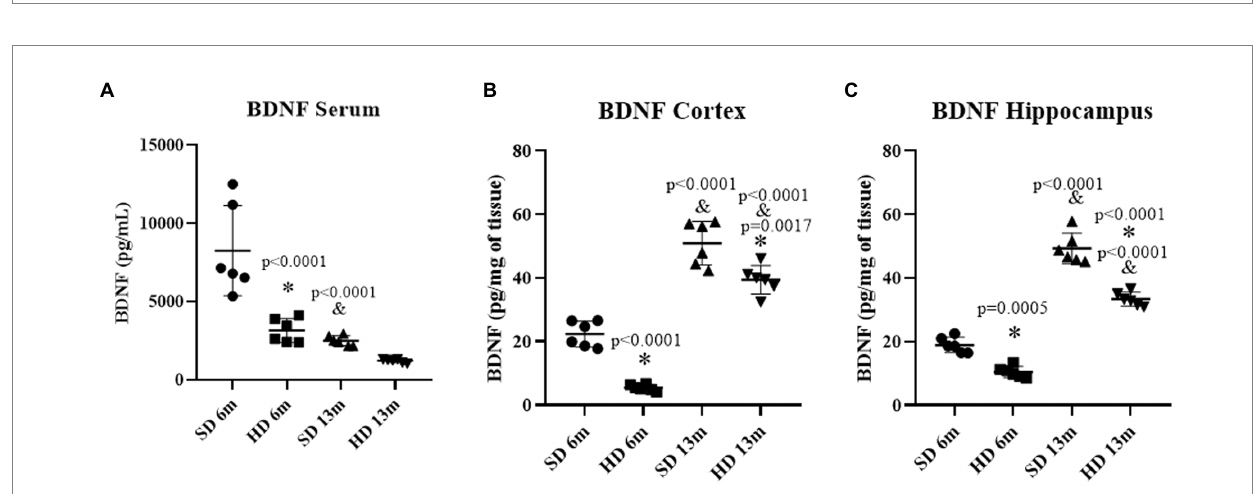
FIGURE 5 Brain Derived Neurotrophic Factor levels. The levels of BDNF in serum (A) , cortex (B) , and hippocampus (C) were determined by ELISA ( n = 6 SD and n = 6 HD). The data represent the mean ± SD and were analyzed by two-way ANOVA, followed by Tukey’s post hoc test. The significant differences between groups compared to the SD are marked with ∗ , and differences at different ages are marked with & p <